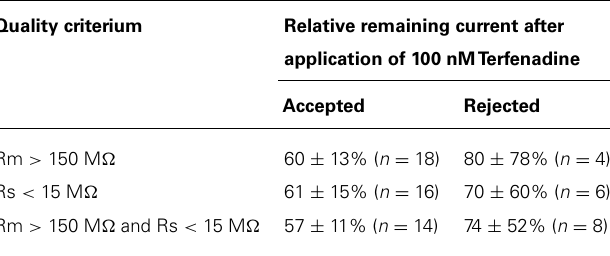
Table 1 | Influence of quality control on the relative remaining hERG current after block with 100 nMTerfenadine. Quality criterium Relative remaining current